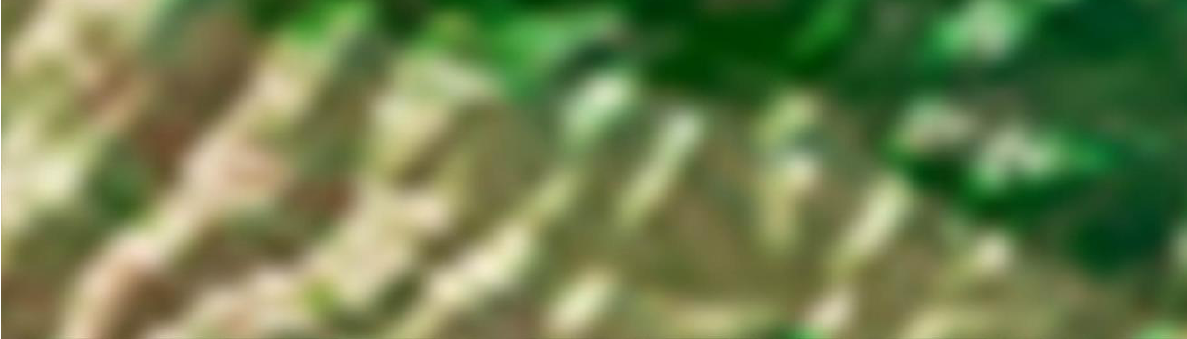
Figure 8. The combination of MODIS image with SRTM-30. Full resolution reduced 2x to show greater area (scale 1:400 000 approx)